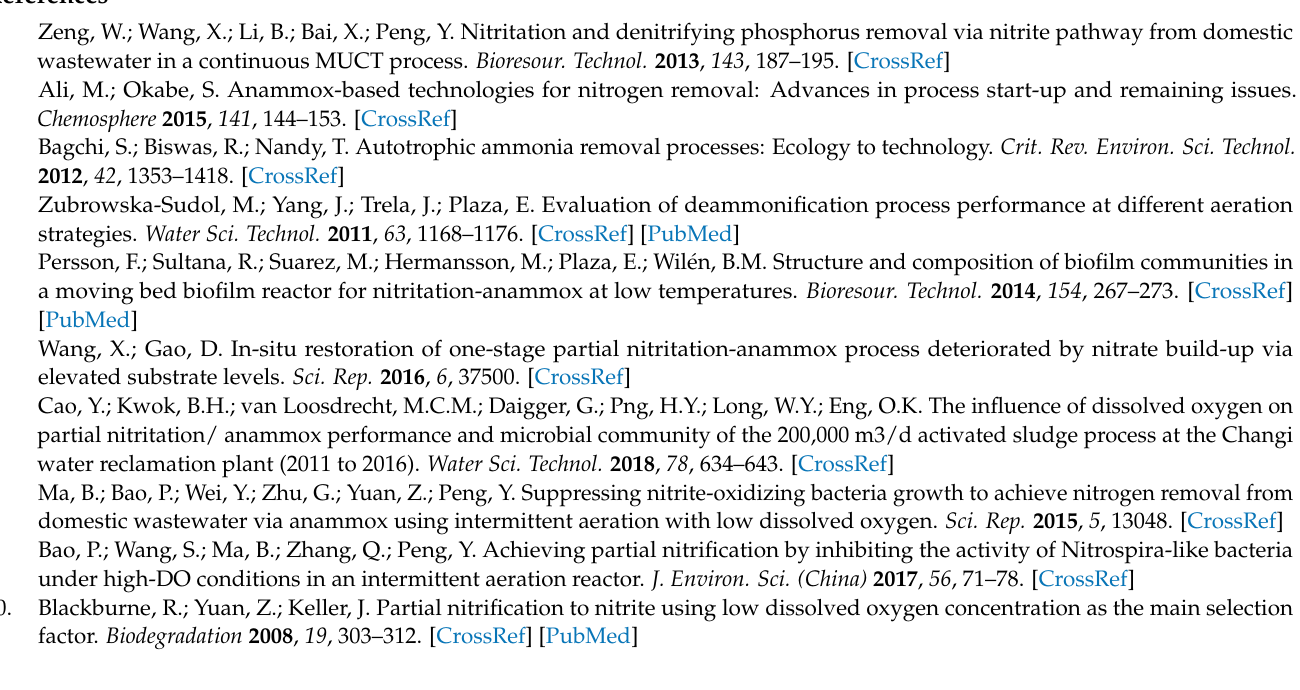
Figure S4: N-NH 4+ , N-NO 2 − , N-NO 3 − profiles during test (a) AUR-B (b) NitUR-B. Stage II; Figure S5: N-NH 4+ , N-NO 2 − , N-NO 3 − profiles during test (a) AUR-SB (b) NitUR-SB. Stage III; Figure S6: N- NH 4+ , N-NO 2 − , N-NO 3 − profiles during test (a) AUR-B (b) NitUR-B. Stage III; Figure S7: N-NH 4+